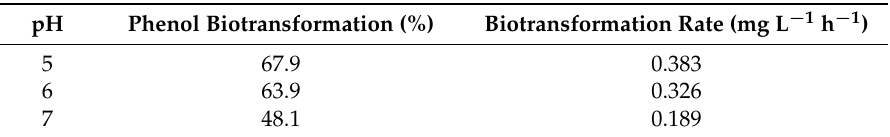
Table 3. Phenol biotransformation at variable pH levels by laccase immobilized onto silica-coated magnetic nanoparticles (FeO-2206W) for 24 h.